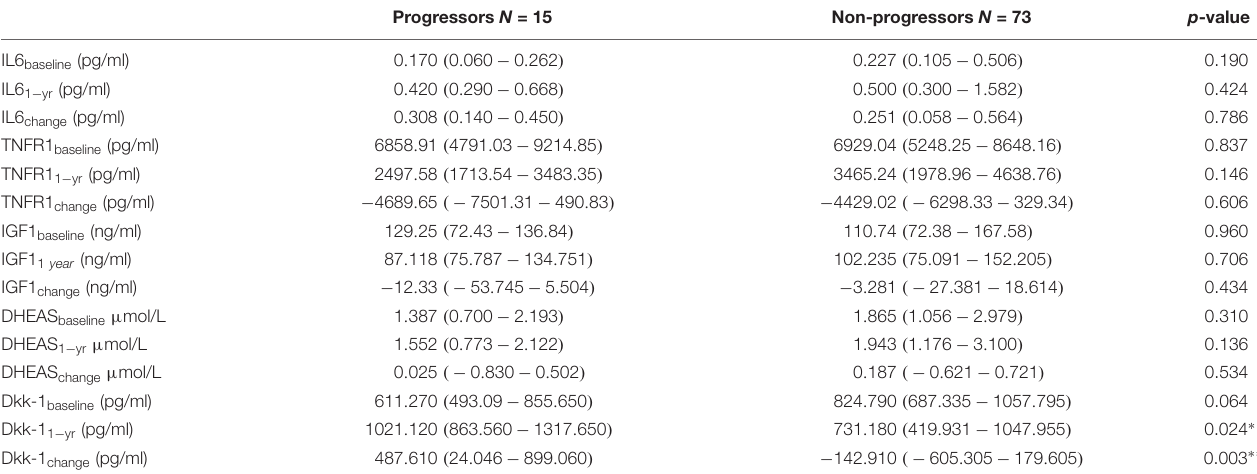
TABLE 2 | Blood biomarkers and disease